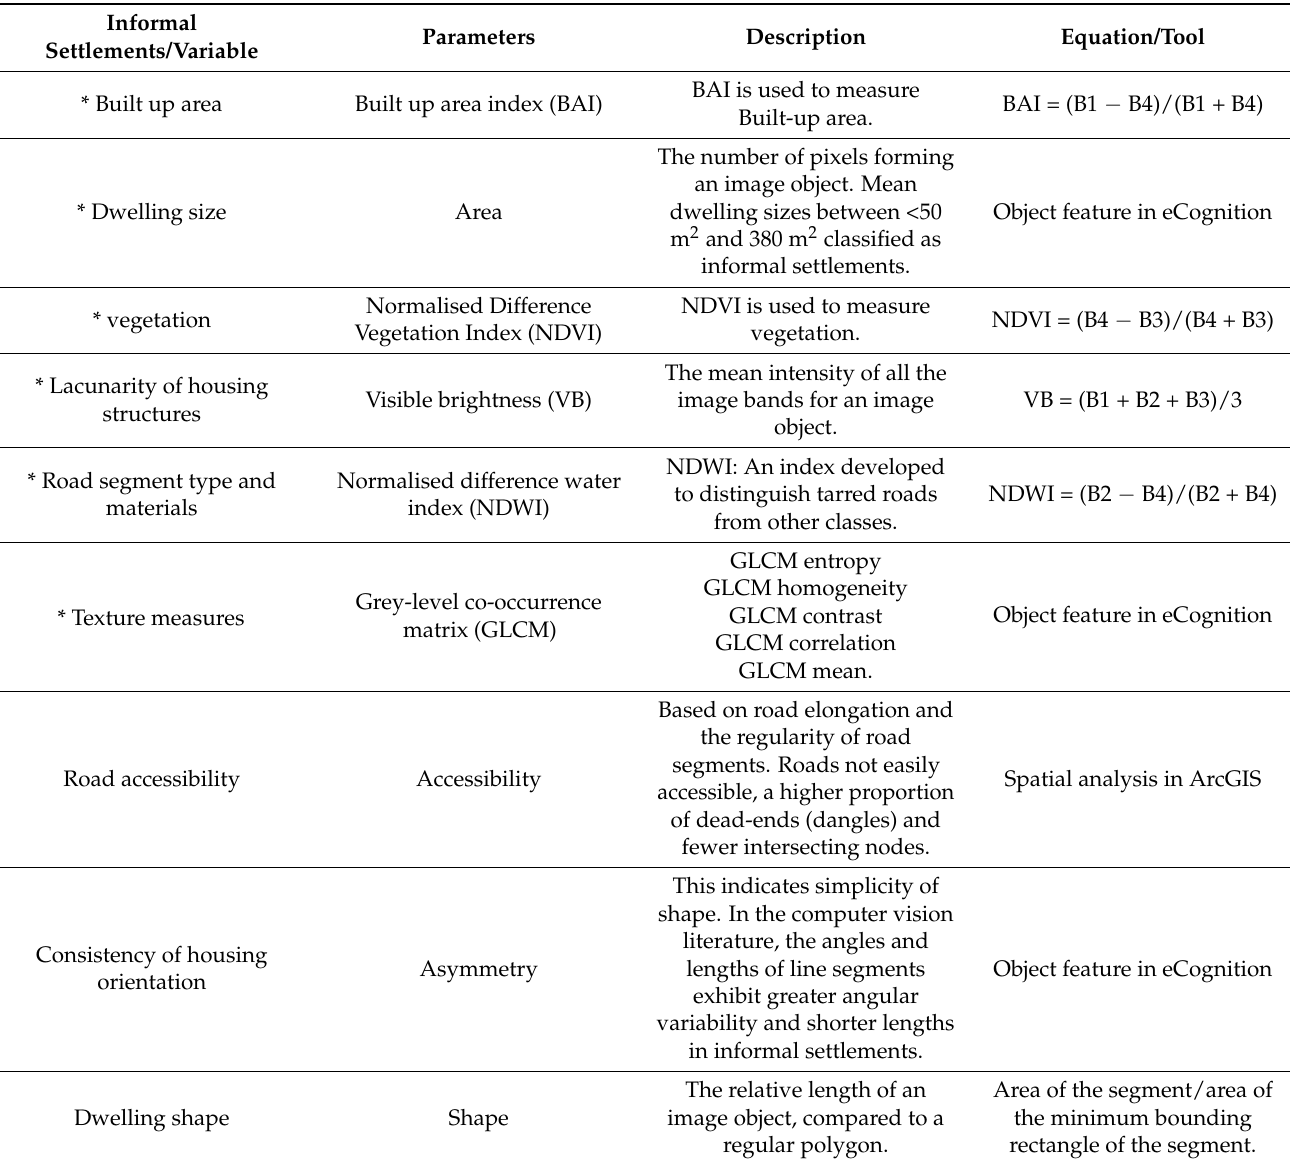
Table A1. Informal settlement indicators and parameters used for object-based ML classification in the Middle East environment. The first six indicators appended with (*) were used only in the [25], using the OBIA approach. In this work, all the informal settlement indicators were